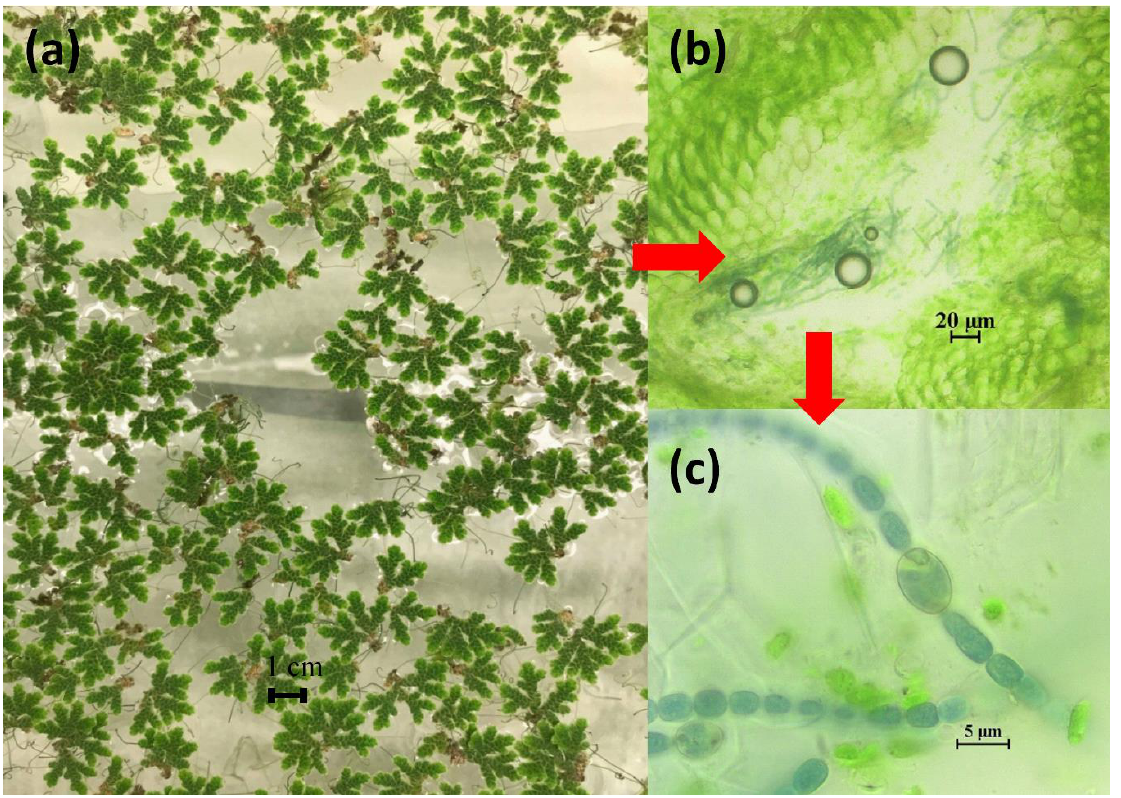
Figure 1. ( a ) Culture of A. filiculoides under laboratory conditions on IRRI medium; ( b ) filaments of A. azolla e in a leaf cavity; ( c ) close up of A. azollae ; both pictures taken from the light microscope at magnifications of 10x and 100x, respectively (Nikon Eclipse 80i, Nikon Instruments Europe B.V., Amsterdam, the Netherlands). Photo: A. Banach.